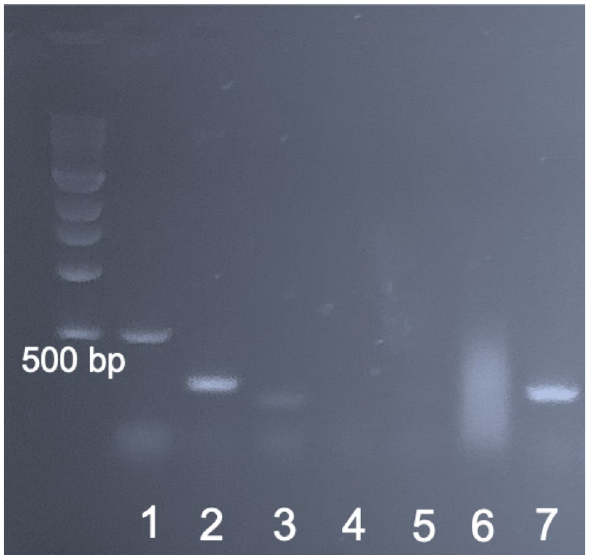
Figure 1. A representative agarose gel of HPV PCR products from one cervical cancer specimen with HPV 18. Lane 1: HPV 18 detectable as 536 bp band; Lane 2: HPV type 18 detectable as 274 bp band; Lanes 3–6: No HPV detected; Lane 7: β-globin (positive control). See Supplementary Table (ST 1) for a complete list of primers